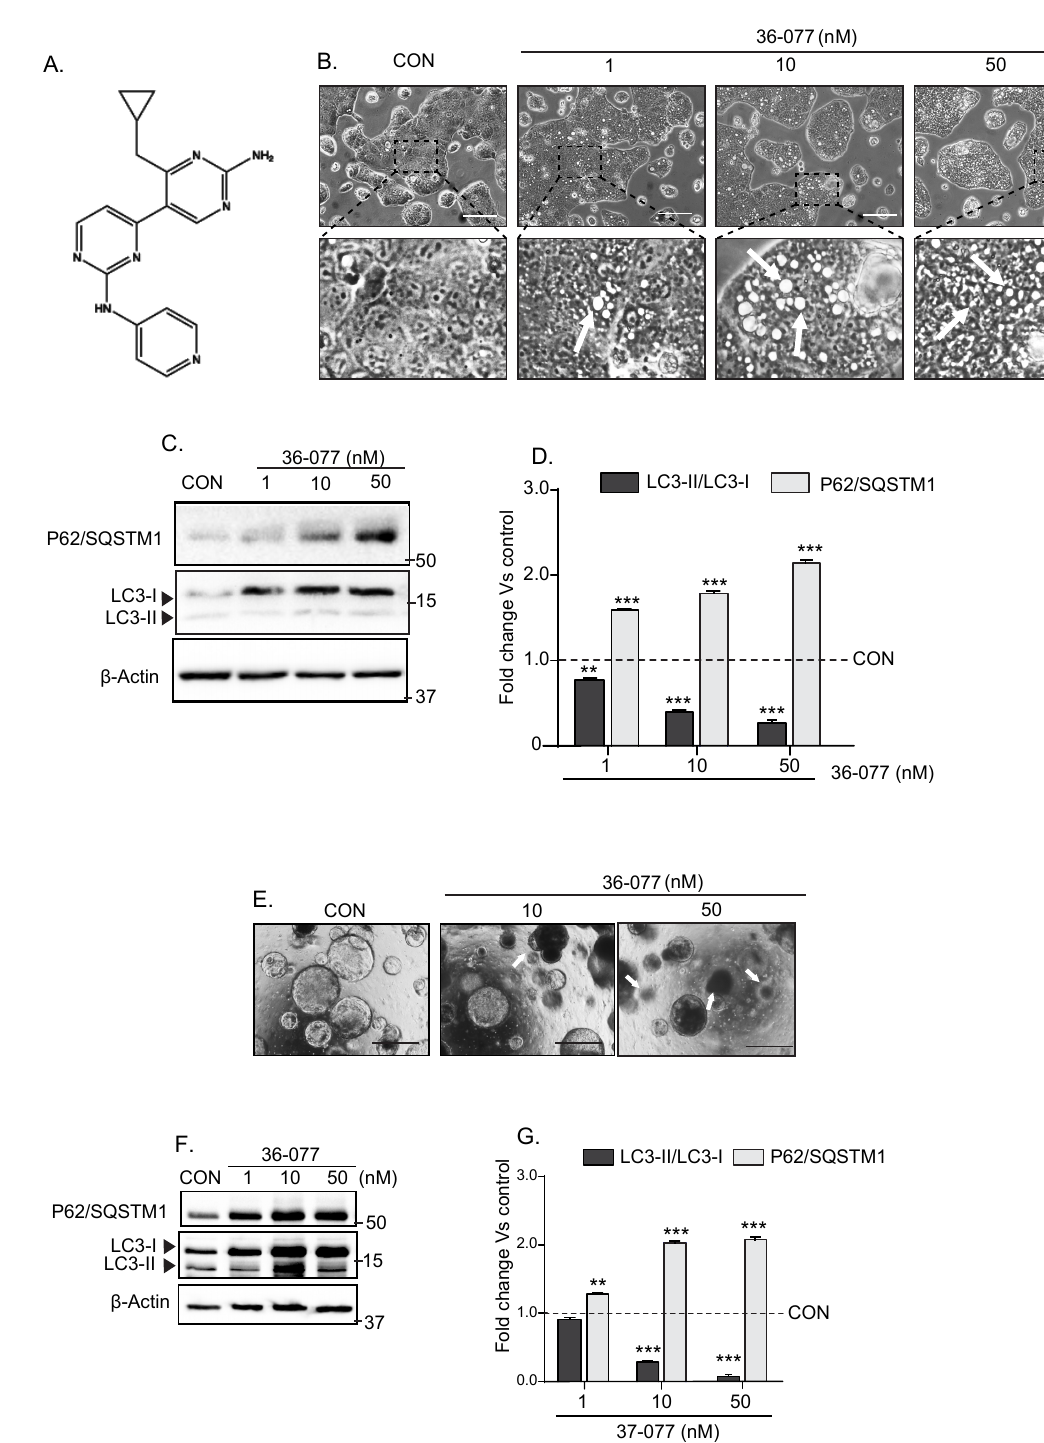
Figure 3. PIK3C3/VPS34 inhibitor 36-077 inhibits autophagy and induces cell death in colon cancer cells and 3D-cultured colon tumoroids. Caco-2 cells, HCT116 cells, or 3D-culture of the APCMin/+ mice-derived colon tumors were treated with 36-077 and the status of autophagy flux was analyzed. ( A ) Chemical structure of 36-077; ( B ) phase-contrast images of Caco-2 cells subjected to 36-077 treatment (dose-response). Arrows indicate vacuoles; ( C , D ) representative immunoblot analysis for P62/SQSTM1 and LC3-I/LC3-II expression in Caco-2 cells subjected to 36-077 treatment (dose-response); ( E ) phase-contrast images of colon tumoroids subjected to 36-077 treatment (dose- response). Arrows indicate shrinking and dying tumoroids; ( F , G ) immunoblot analysis of P62/SQSTM1 and LC3-I/LC3-II expression using lysates from the control and 36-077-treated colon tumoroids. Statistical significance was determined by 1-way ANOVA. *** p < 0.001 and ** p < 0.01. Scale bar = 100 µ